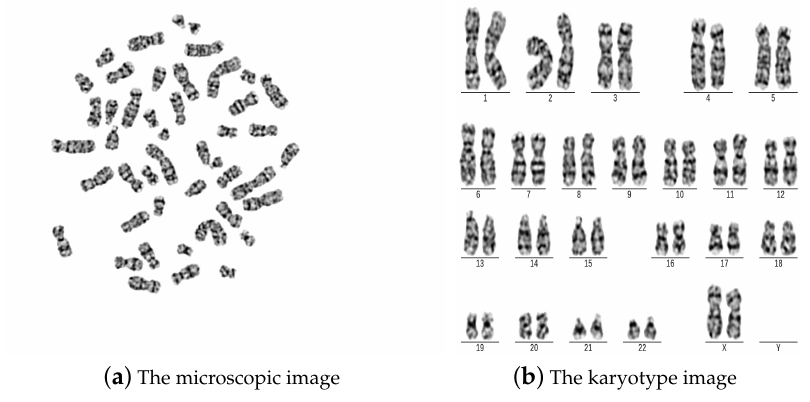
Figure 1. A chromosome microscopic image ( a ) and the corresponding karyotyping image ( b